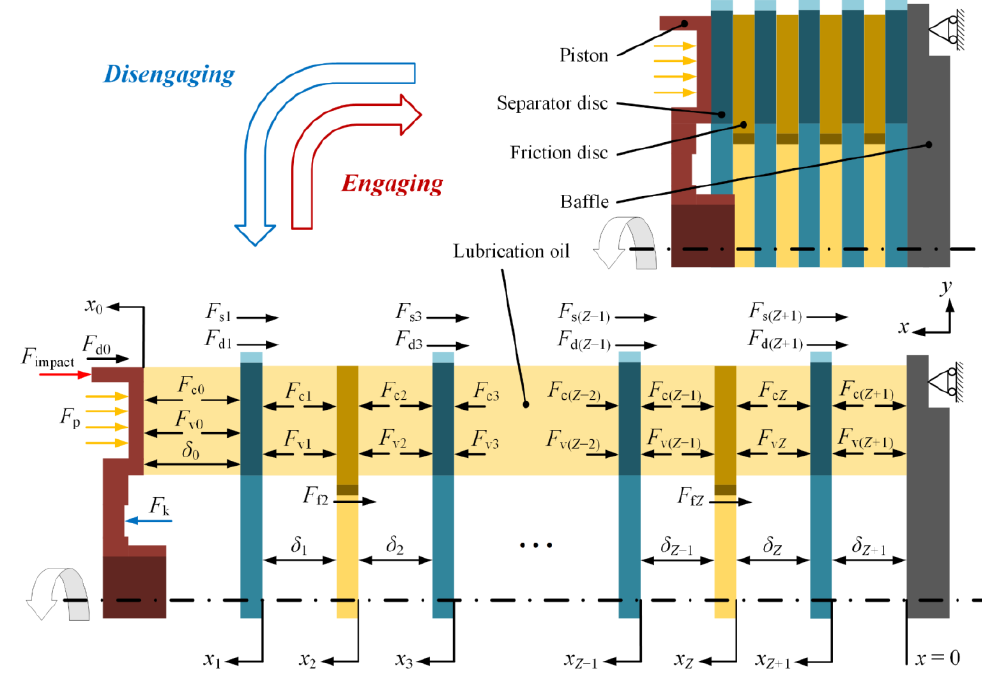
Figure 2. Axial force analysis for a wet multi-disc clutch.